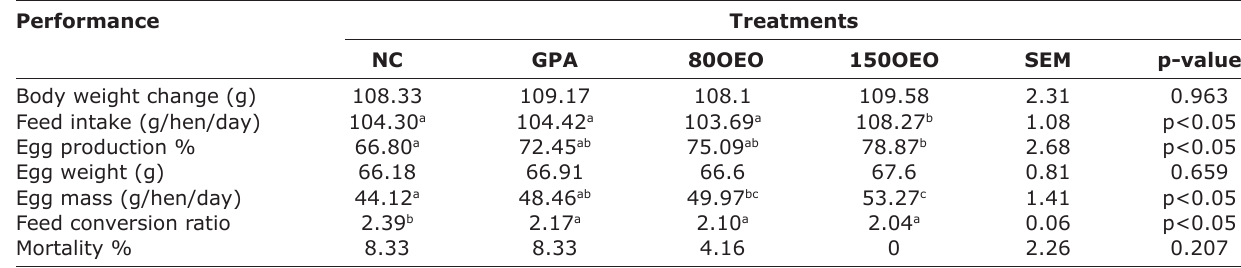
Table-2: Effect of the inclusion of oregano essential oil on the performance in Isa Brown hens.